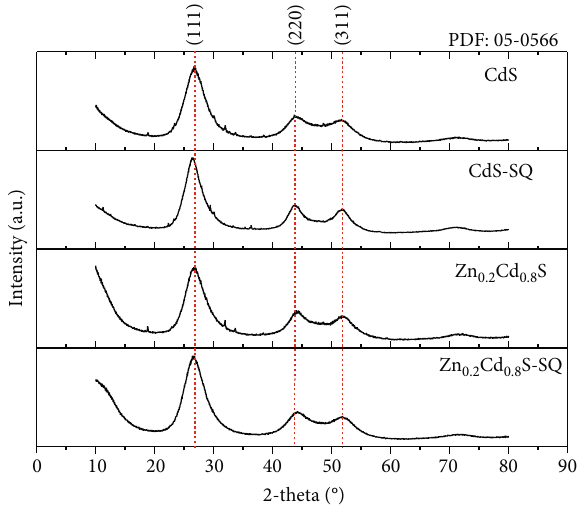
Cd S solid 0.2 0.8